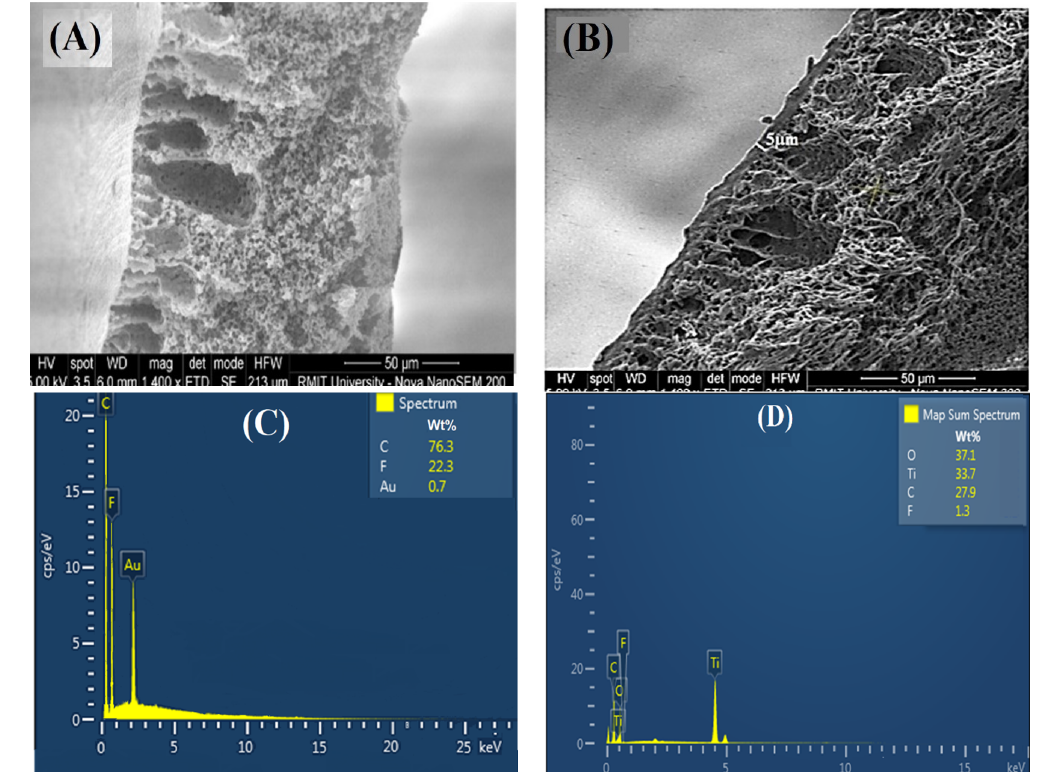
Figure 4. The SEM images of cross-sections of plain and modified PVDF membranes: ( A ) plain PVDF membrane (0 wt.% TiO 2 ) and ( B ) TiO 2 /PVA modified PVDF membrane (1 wt.% TiO 2 ); and the corresponding EDX images of the top surface of the membrane ( C ) plain PVDF membrane (0 wt.% TiO 2 ) and ( D ) TiO 2 /PVA modified PVDF membrane (1 wt.% TiO 2 ). Table 3. Surface roughness parameters at different TiO 2 loading on the PVDF membranes obtained from AFM images (Figure 3).